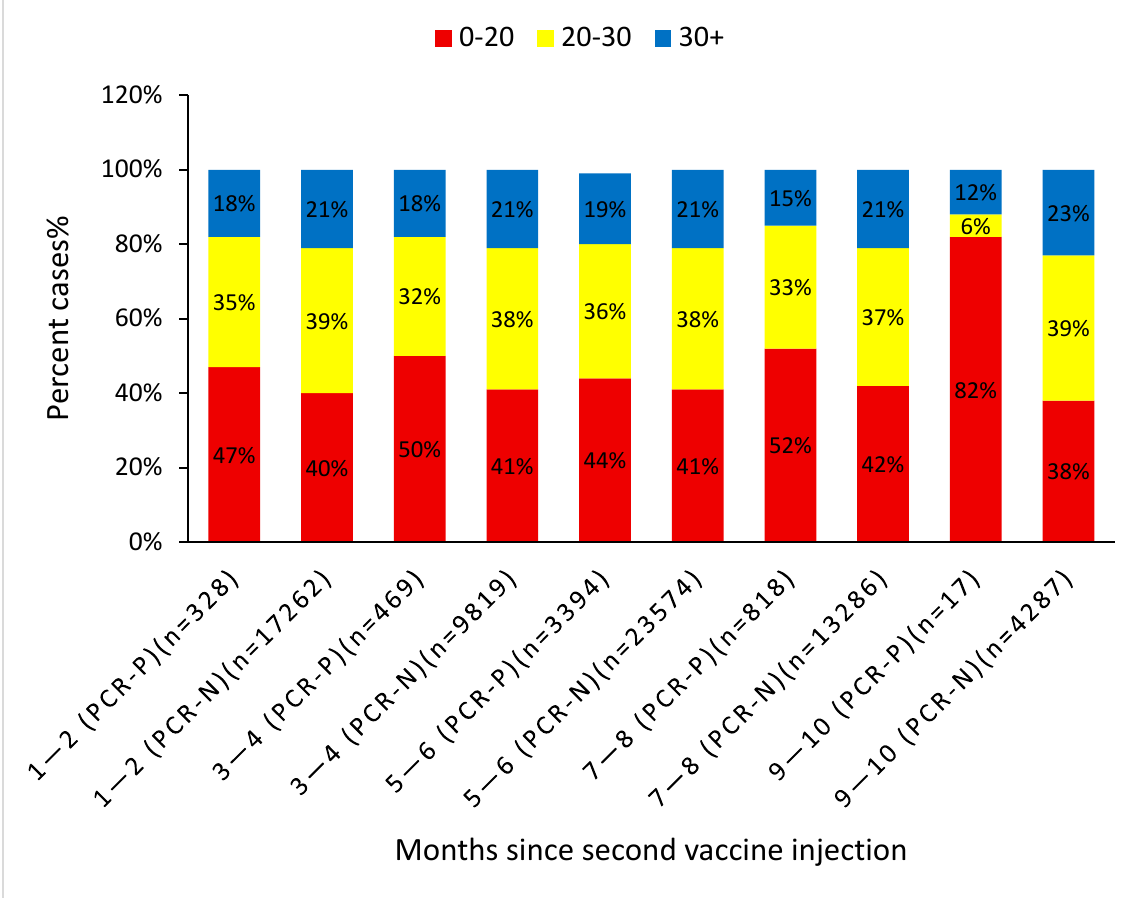
Figure 2. Percent cases with negative/positive RT-PCR classified by baseline 25(OH)D levels at each time point following the second vaccination. The Pearson Chi-square test was applied here.